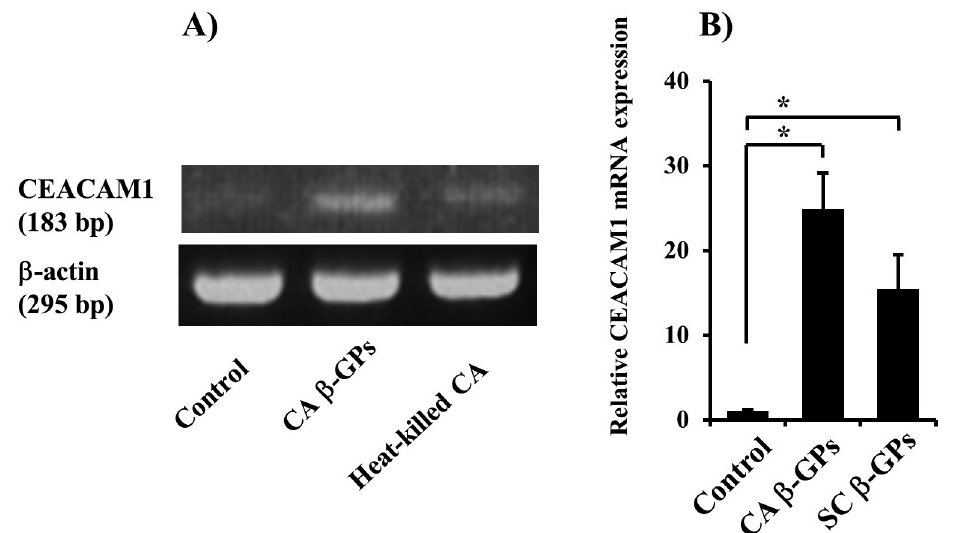
Figure 3- Effects of fungal β-GPs on CEACAM1 mRNA expression in RT7 cells (A) Cells were incubated with C. albicans β-glucan-containing particles (CA β-GPs) (200 μg/mL) or heat-killed (108/mL) C. albicans (CA) for 12 hours. Gene mRNA levels are presented as relative to that of β-actin. Then, RT-PCR assays were performed for CEACAM1 and β-actin. The experiments were performed at least three times, with representative results shown. (B) Cells were incubated with CA β-GPs (200 μg/mL) or S. cerevisiae β-GPs (SC β-GPs) (200 μg/mL) for 12 hours. Gene mRNA levels are presented as relative to that of β-actin. Values are shown as fold increase as compared with non-treated cells and presented as the mean ± SD of three independent experiments. *Significantly different from non-treated control (Bonferroni/Dunn's multiple comparison test: